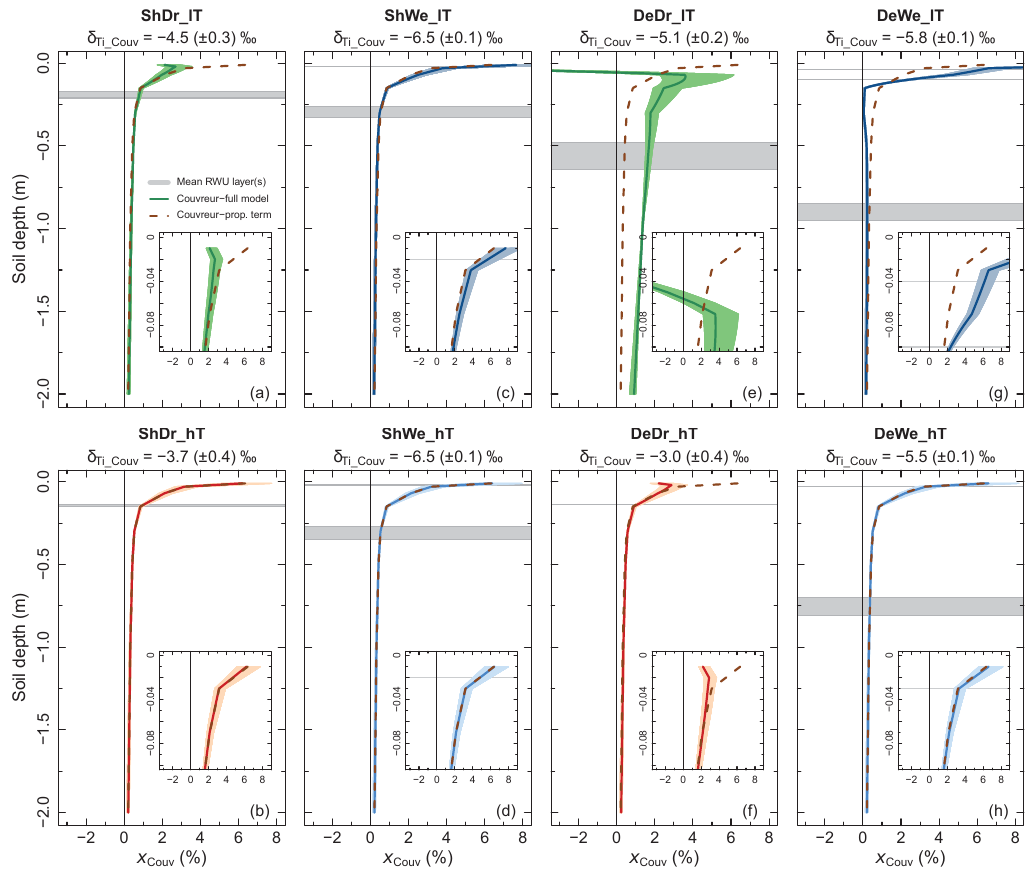
Figure 5. Simulated depth ( z , in m) profiles of x Couv (%) (solid colored lines), the simulated relative contributions to transpiration provided by the model of Couvreur et al. (2012) for experiments “ShDr” (soil with a shallow groundwater table and a relatively dry soil surface), “ShWe” (soil with a shallow groundwater table after a rainfall event), “DeDr” (soil with a deep groundwater table with a relatively dry soil surface), and “DeWe” (soil with a deep groundwater table and a wet soil surface). Suffices “lT” and “hT” refer to “low” and “high” transpiration rate simulations. The color-shaded areas depict the uncertainty of the model estimates on account of the precision of the measurements. The horizontal gray-shaded areas delimit the mean root water uptake layer(s) obtained by the graphical inference method. At the bottom right corner of each plot is a detail presented for z ≥ − 0 . 10m. Finally, results from the first term of the model of Couvreur et al. (2012) which considers uptake proportional to root length density are plotted as a dashed brown line for comparison. Note that negative x Couv means hydraulic redistribution by the